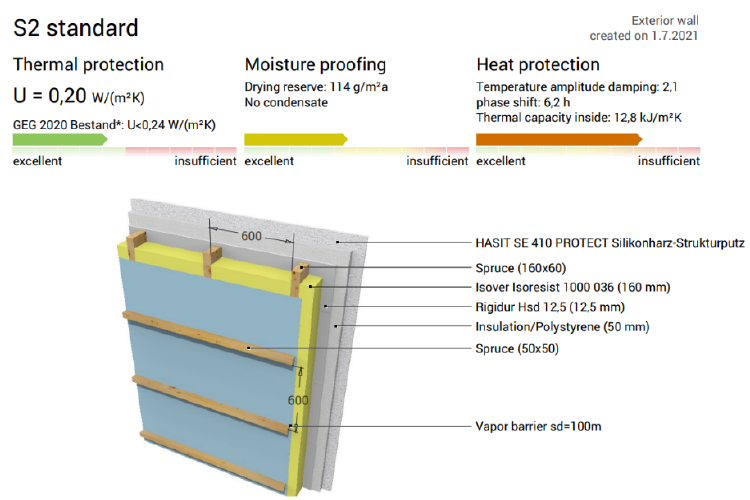
Figure 23. A section through a wall in a standard frame building.